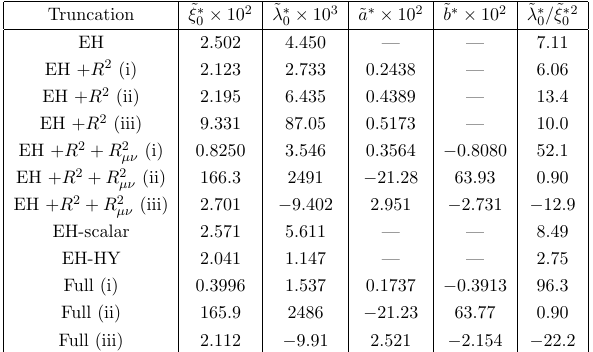
Table 3 . The values of (cid:12)xed points for (cid:11) = 0 and (cid:12) = 0.